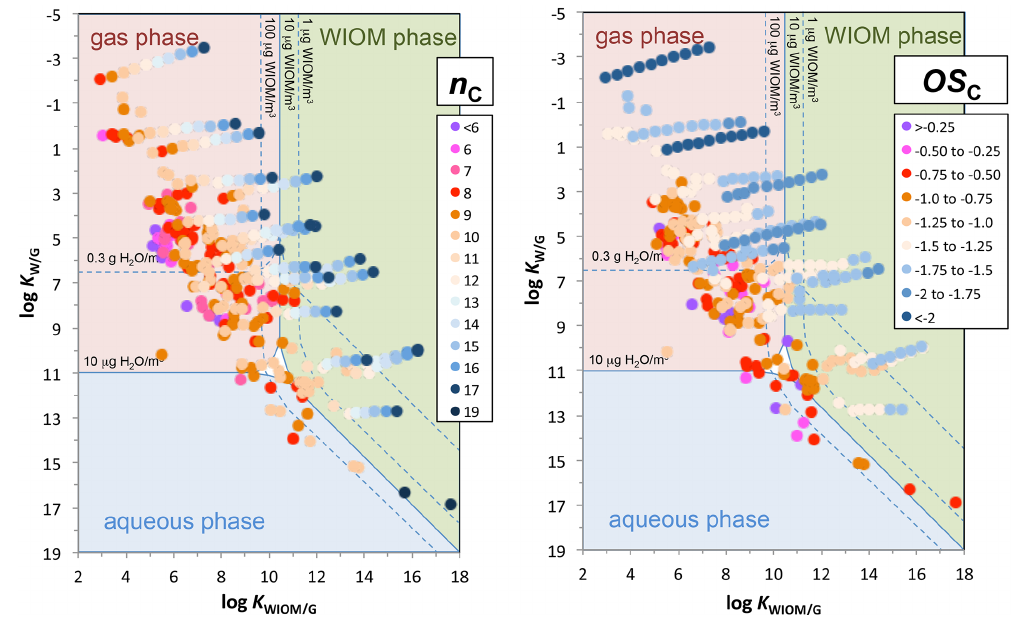
Figure 3. Same as Fig. 2, except that markers are coloured based on a chemical’s number of carbon atoms ( n C ) (left) or its average carbon oxidation state (OS C )